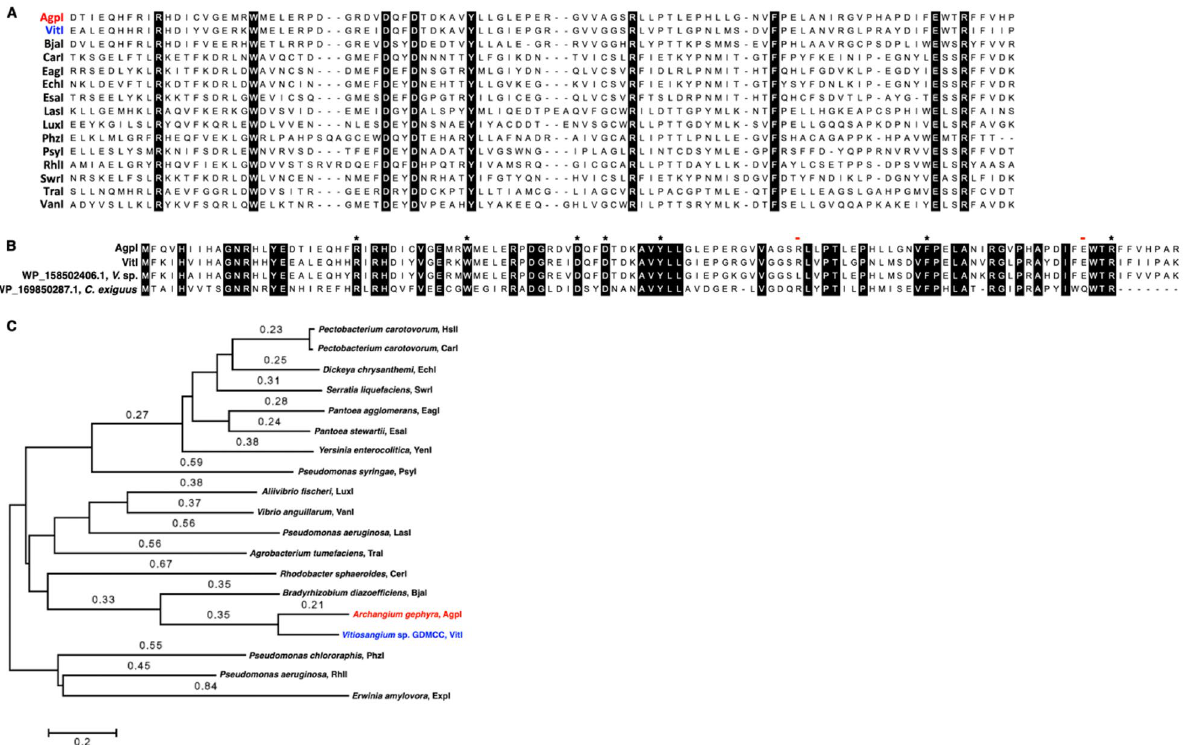
Figure 2. ( A ) Alignment of LuxI synthases including AgpI and VitI with conserved residues boxed in black. ( B ) Alignment of myxobacterial features homologous to AgpI with asterisks (*) indicating conserved residues associated with the LasI autoinducer domain (COG3916) and red lines (-) indicating residues from the LasI domain that are not conserved. ( C ) Minimum Evolution tree including AgpI and VitI rendered in MEGA7 using ClustalW aligned with AHL synthases experimentally confirmed to produce AHLs (68). Branch lengths ≤ 0.2 not